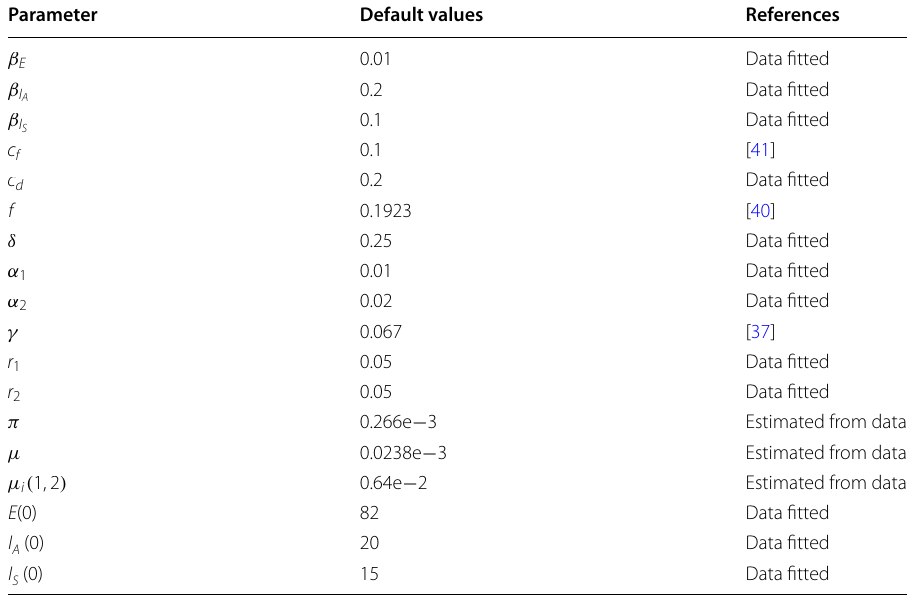
Table 3 Base values of parameters used in Eq. (1)